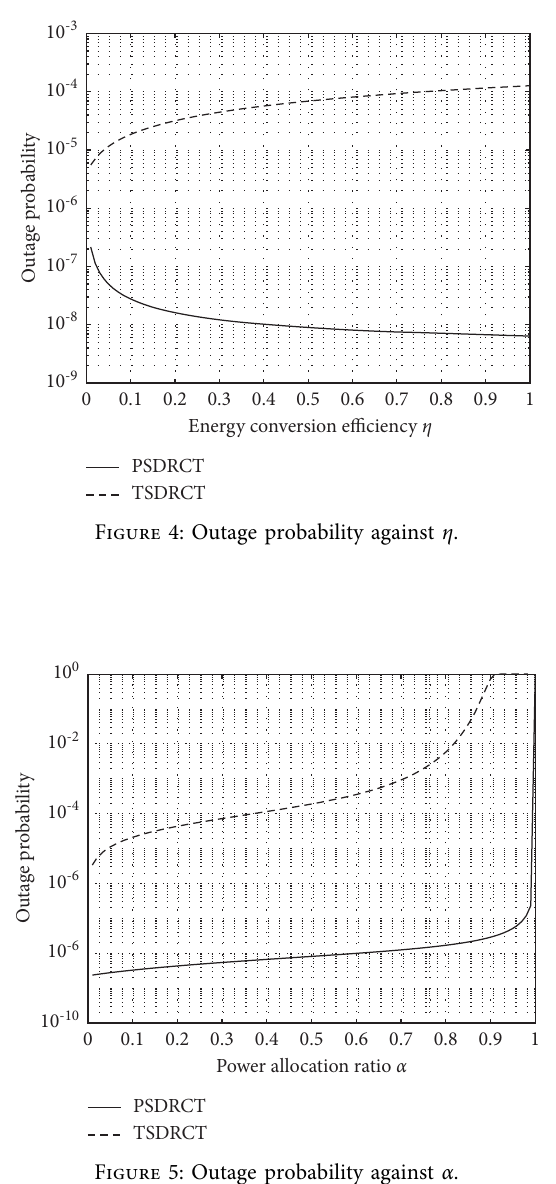
Figure 7, the location and energy efficiency of relay nodes show a normal distribution trend; at the same time, η is proportional to the energy efficiency. According to Figures 3